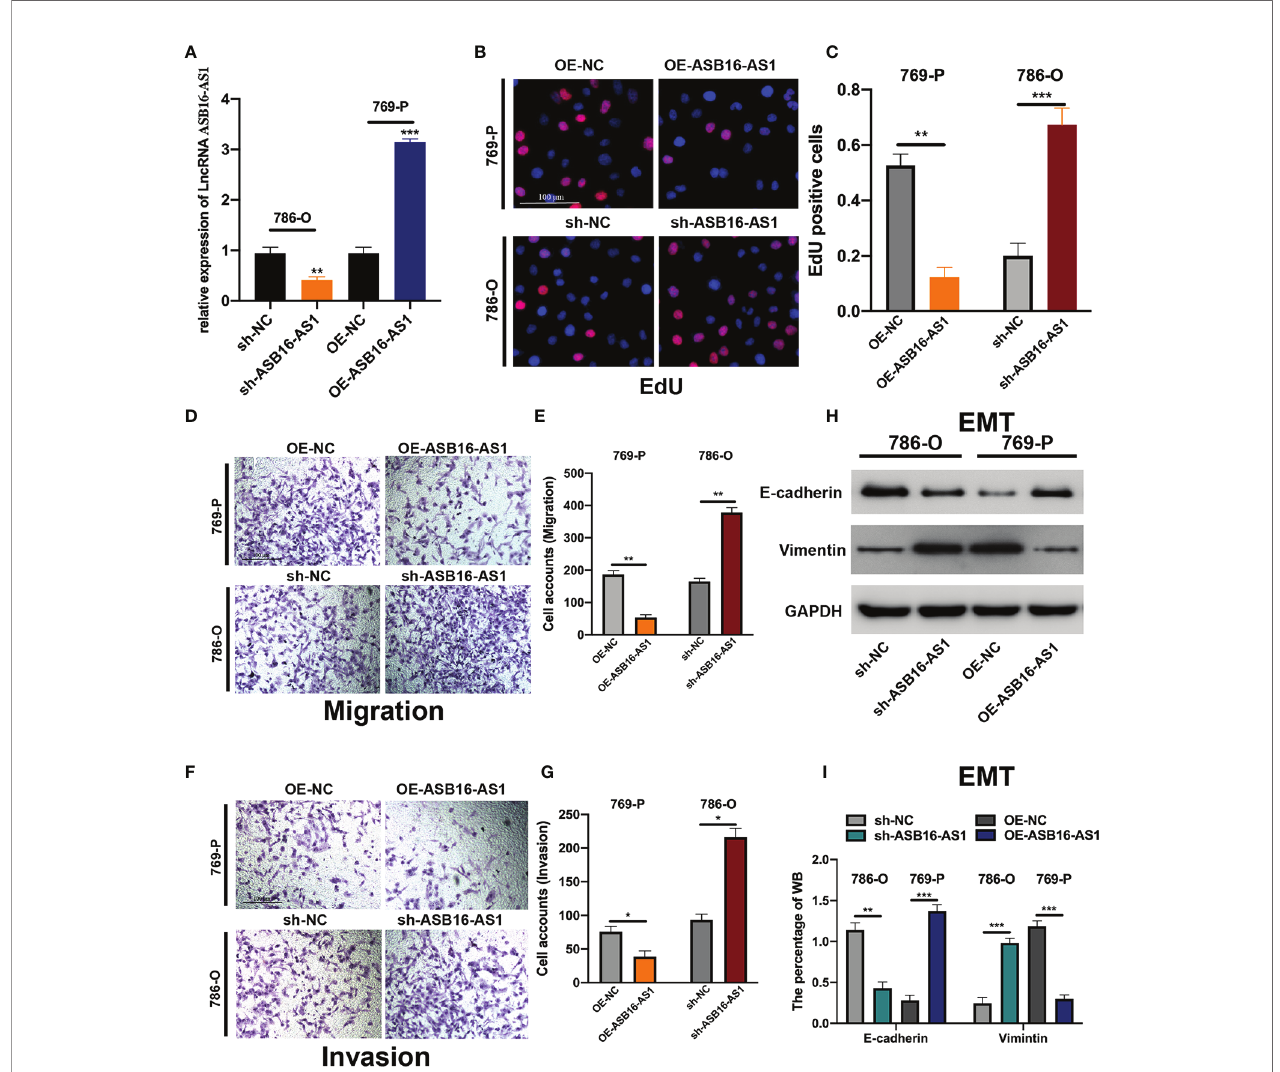
FIGURE 2 | ASB16-AS1 downregulation promotes renal cell carcinoma (RCC) proliferation, migration, and invasion. (A) The transfection ef fi ciency of ASB16-AS1 siRNA/NC and OE/NC in 786-O and 769-P cells. (B) Representative images of EdU positive cells showing proliferation of shRNA treated 786-O and 769P cells, which are quanti fi ed in (C) . (D) Representative images of the transwell migration assays used to detect the migration of shRNA treated 786-O and 769P cells, which are quanti fi ed in (E) . (F) Transwell invasion assays were applied to detect the invasion of shRNA treated 786-O and 769P cells, which are quanti fi ed in (G). (H) Western blots of epithelial-mesenchymal-transition associated genes in shRNA treated 786-O and 769P cells, which are quanti fi ed in (I) . All experiments were repeated at least three times, scale bars -100 m m. *P < 0.05, **P < 0.01, ***P <